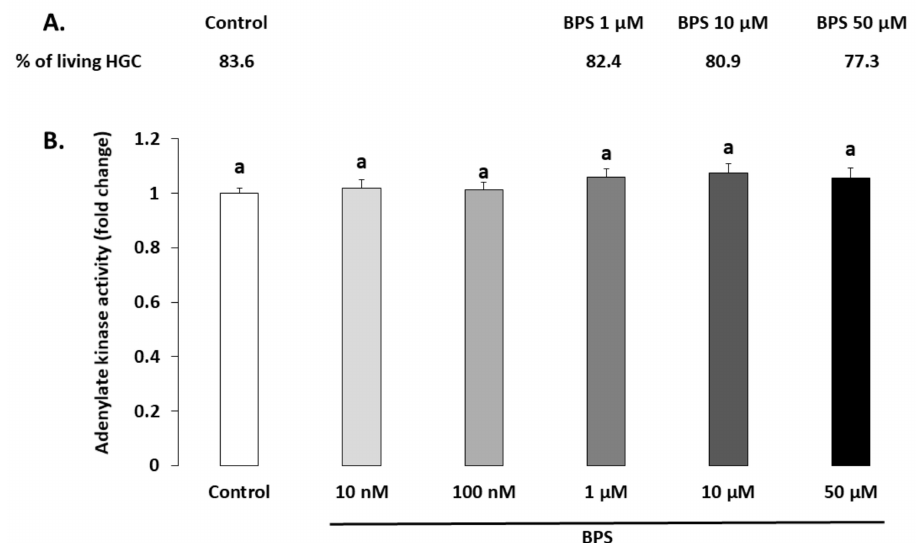
Figure 1. E ff ect of Bisphenol S (BPS) on human granulosa cell (HGC) viability. HGC underwent 48-h culture in the presence or absence of BPS (10 nM, 100 nM, 1 µ M, 10 µ M or 50 µ M). ( A. ) HGC viability was assessed using the Live / Dead Viability / Cytotoxicity Kit for mammalian cells. The results of three independent experiments per condition are expressed as the percentage of living cells in each condition. ( B. ) HGC viability was assessed on spent 48-h culture media using the Bioluminescence Cytotoxicity Assay Kit. Data are expressed as the mean relative light units ± standard error of the mean (SEM) of six independent cultures. Bars with di ff erent superscripts indicate a significant di ff erence ( p ≤ 0.05).